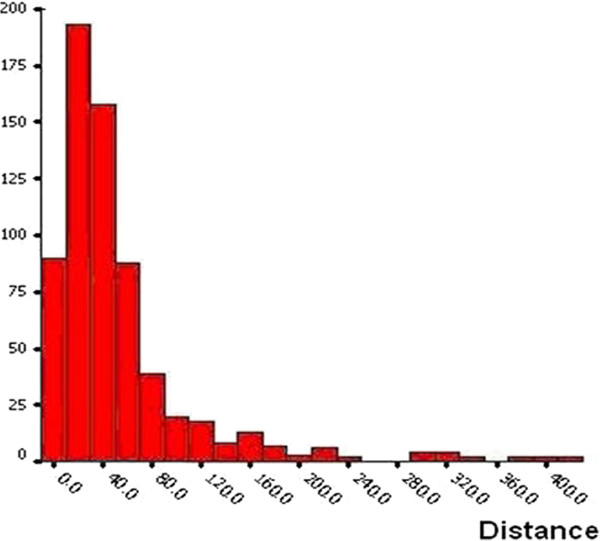
 The statistical distribution of distance from house to water bodies.